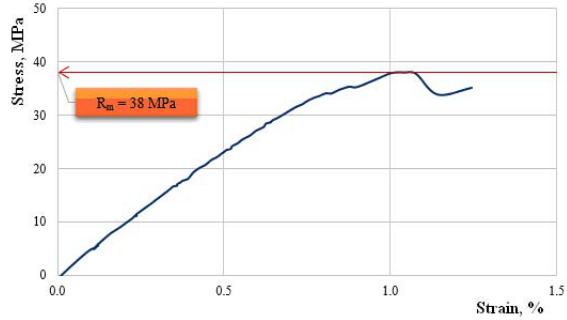
Figure 13. The characteristic curve of a representative sample of wheat straw-reinforced composite material.